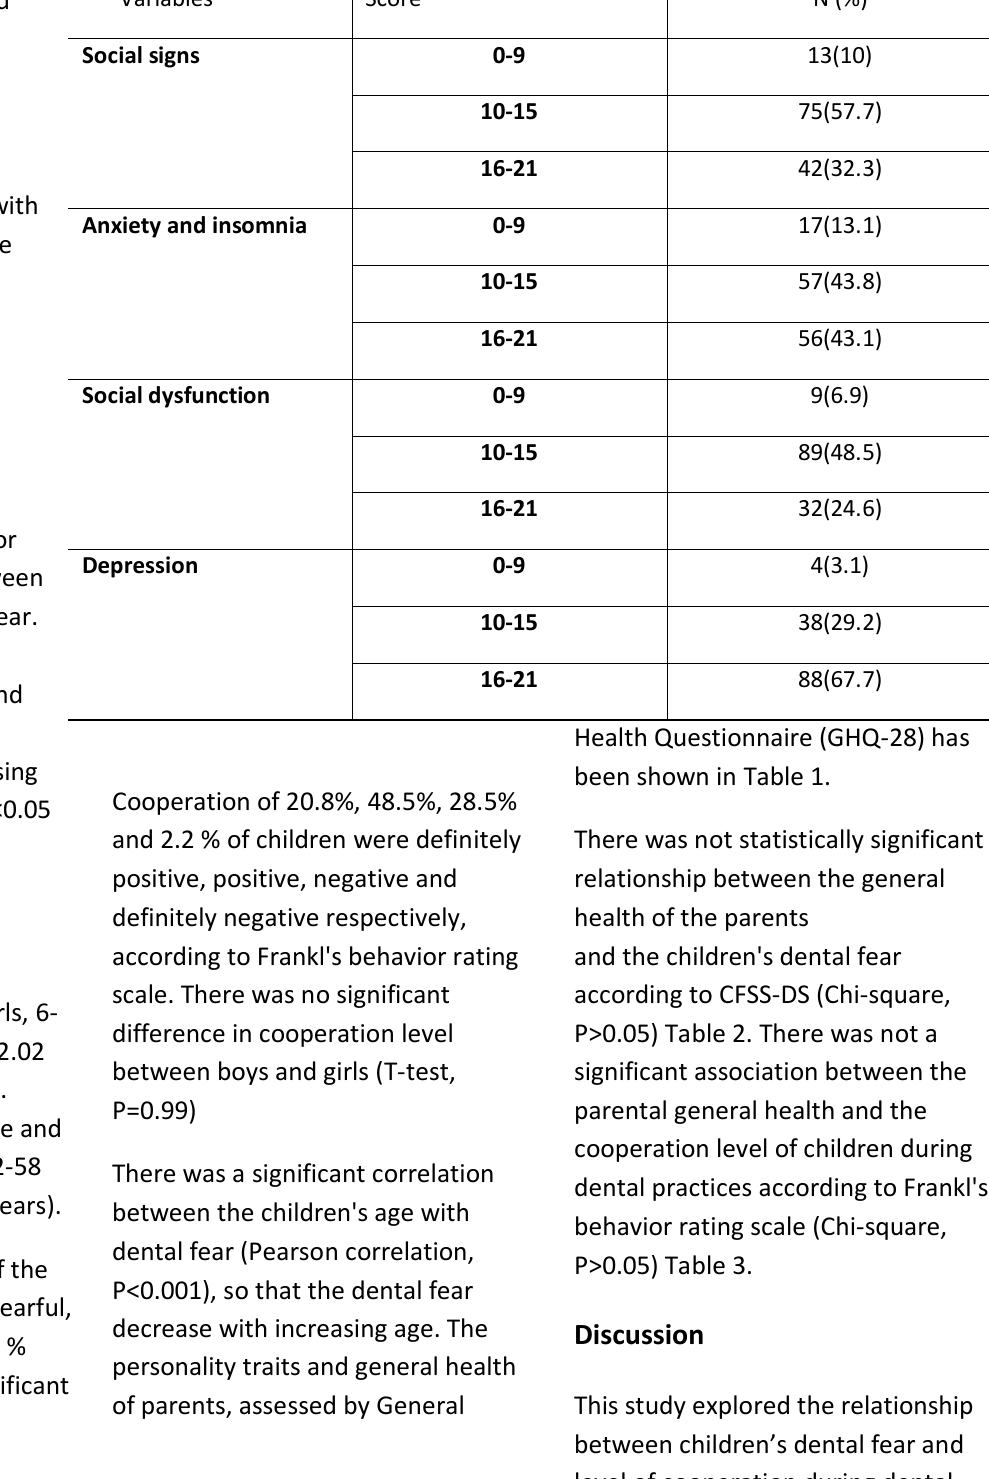
Table 1. Frequency distribution of parental general health by four subscales